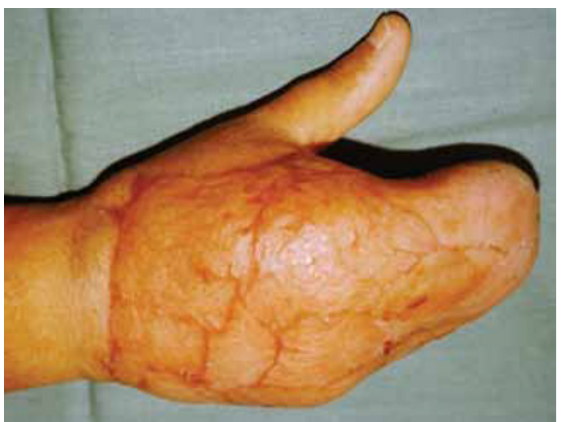
Figure 4. Clinical case 2. An extensive soft tissue defect of the right foot. The skin is avulsed from the dorsal and plantar surfaces of the foot. The heel is not injured.